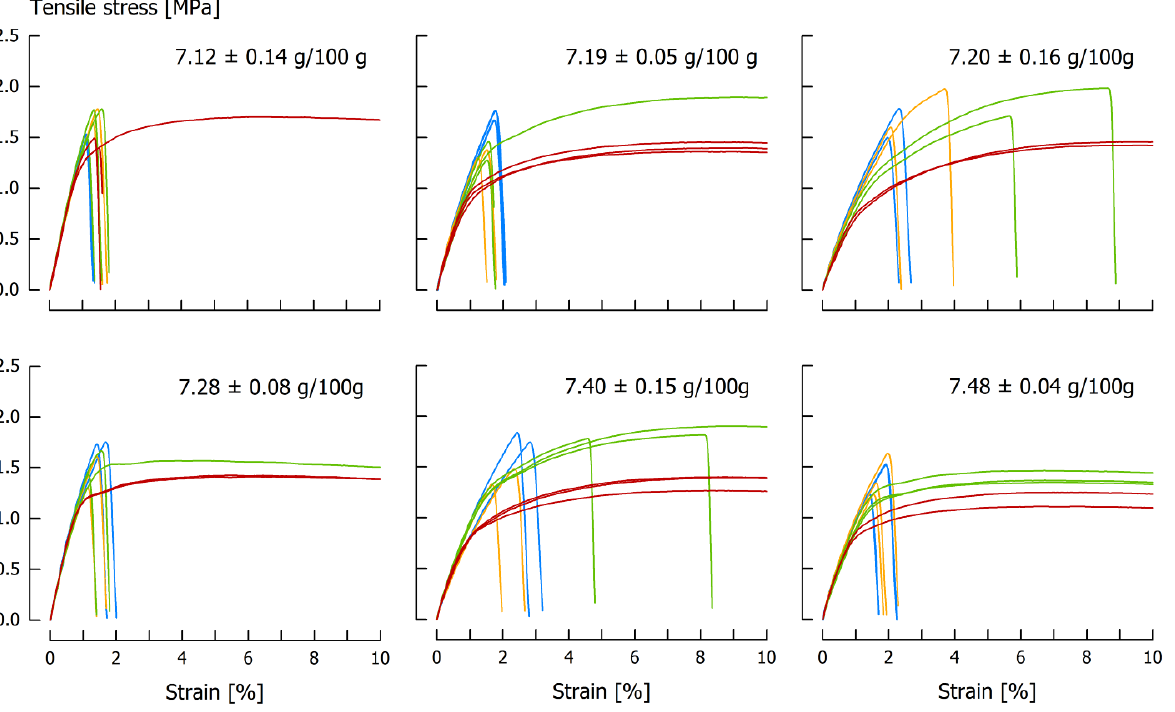
Figure 2. Tensile stress/strain curves of six caramel samples ( T = 25 °C) tested at v = 1000 (red), v = 1375 (green), v = 1750 (yellow) and v = 2500 mm/min (blue). Moisture content of the samples is given in the charts. For the sake of clarity, curves from the v = 2125 mm/min are not displayed.